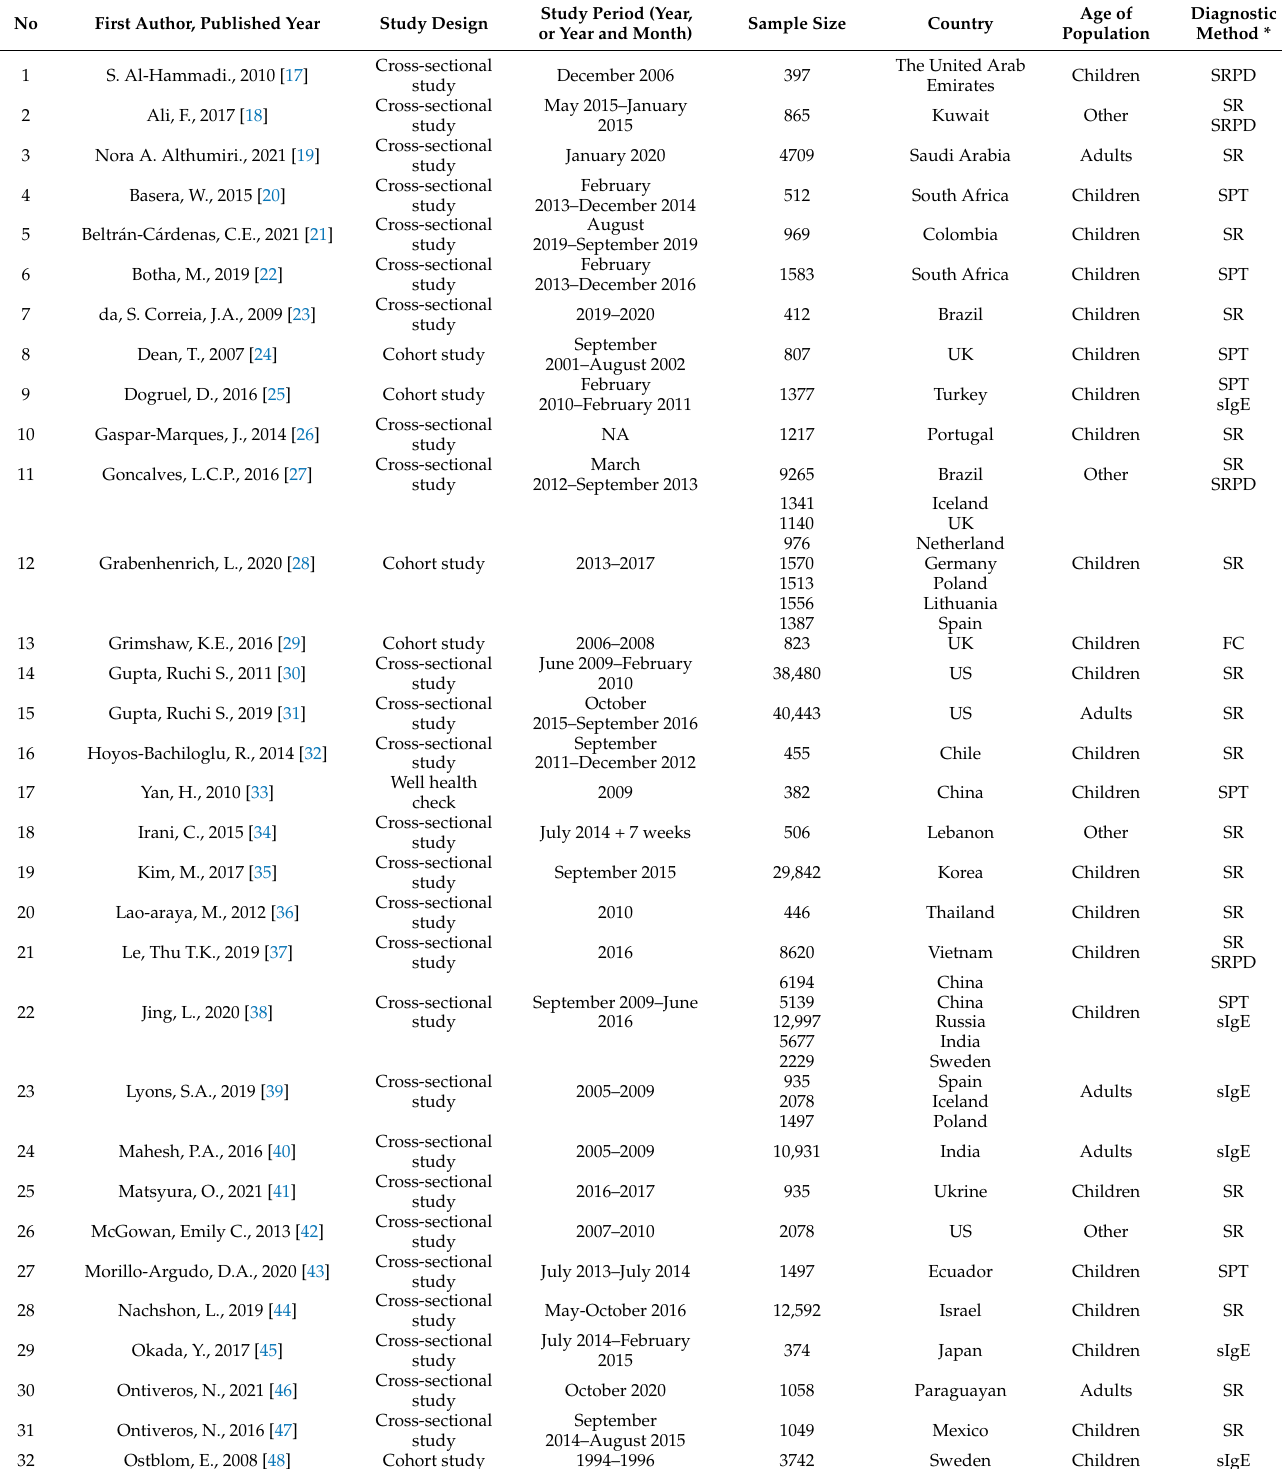
Table 1. Summary of the characteristics of 56 included